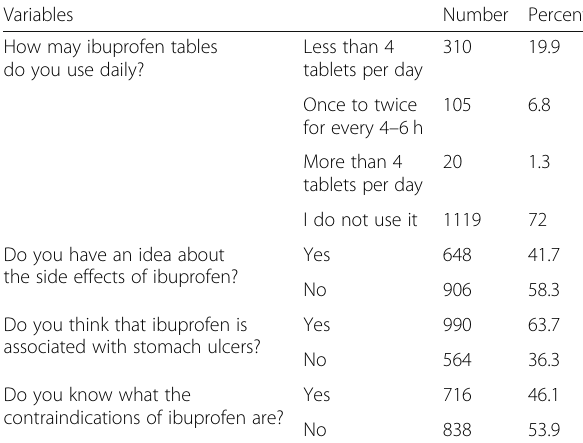
Table 5 Knowledge and awareness of participant